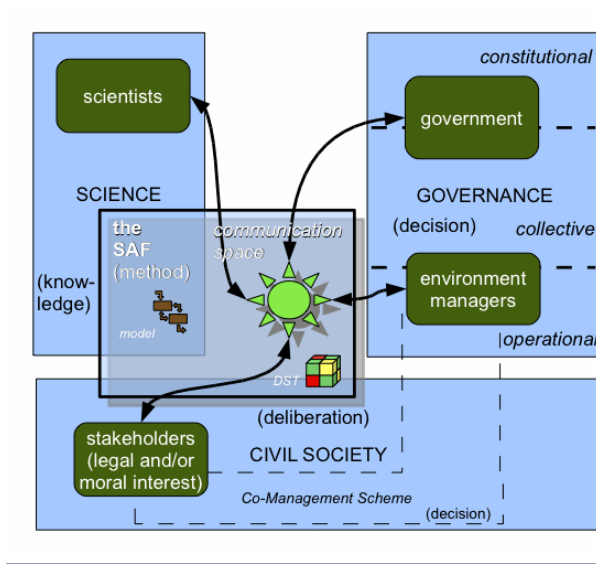
Fig. 2 . Map of the study area. (a) location of the Firth of Clyde and the main study area (Loch Fyne, within the red box) within Scotland. The position of Loch Creran, used for testing the physical-biological model, is also shown. (b) Loch Fyne as defined for the purposes of modeling, and showing relevant